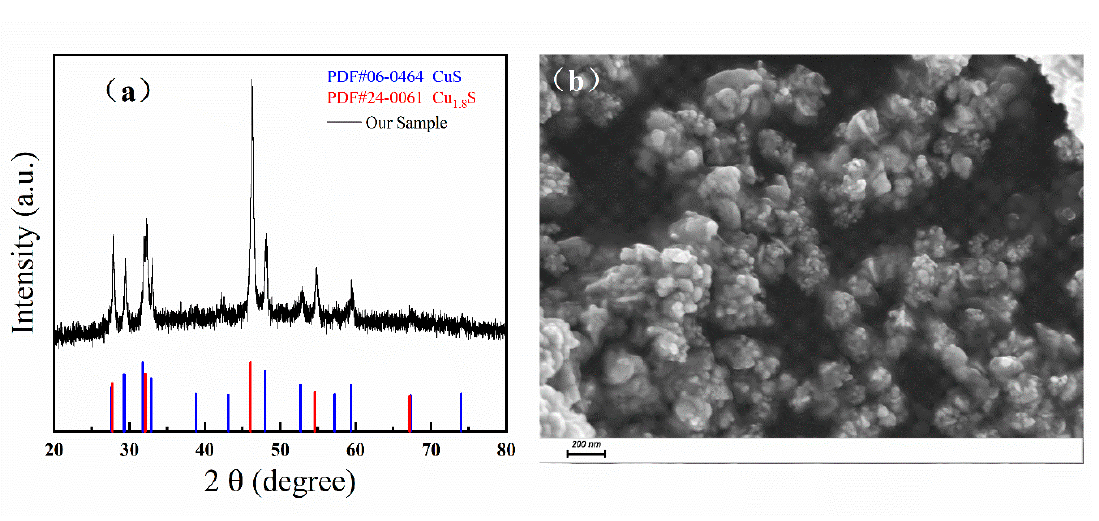
Figure 2. ( a ) XRD patterns of the sample and the stand PDF cards of CuS and Cu 1.8 S. ( b ) The SEM image of our sample with a 200 nm scale bar below.